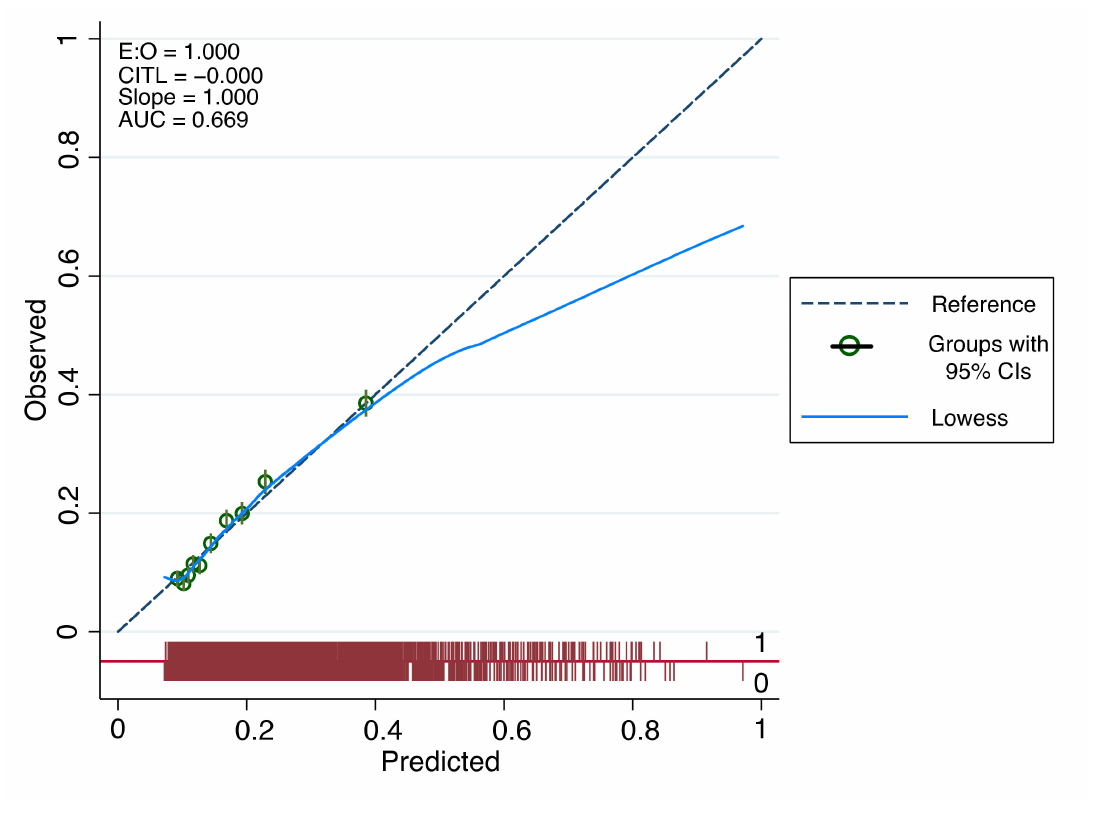
Figure 1. Assessing calibration of model.